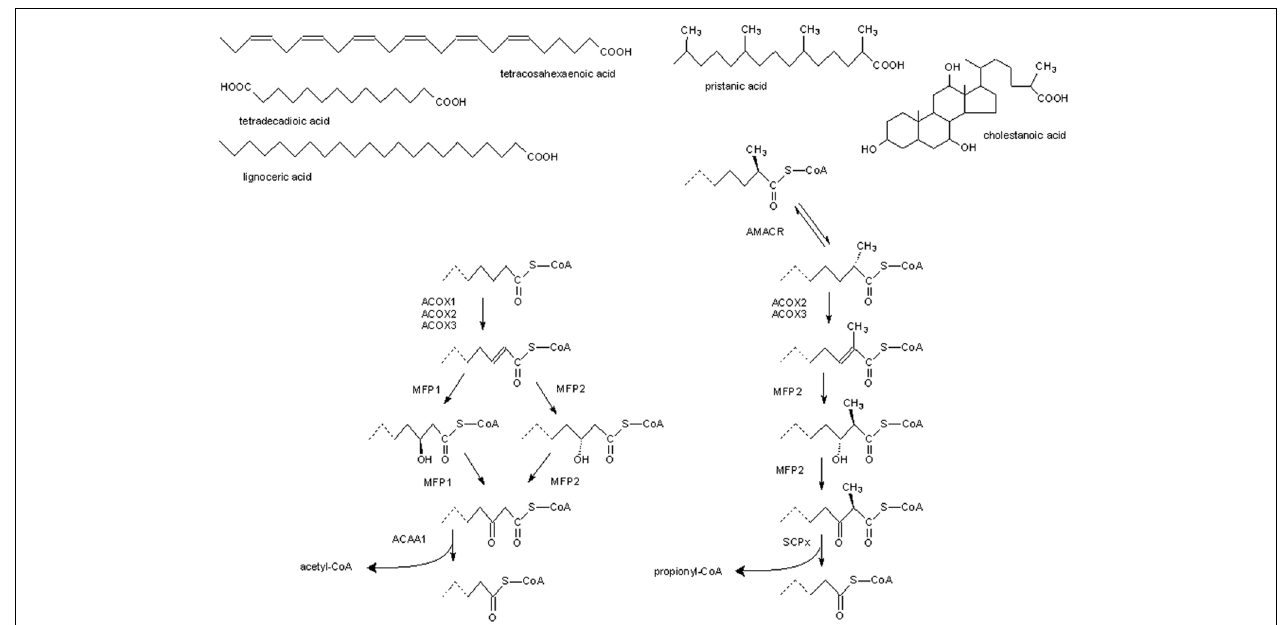
FIGURE 1 | Generalized scheme of peroxisomal β -oxidation in animals. On top , structures of some fatty carboxylates that, after activation (not shown), are degraded by peroxisomal β -oxidation. At the right , enzymatic reactions/enzymes involved in degradation of substrates containing a 2-methylbranch, based on the situation in mammals. Most of these enzymes